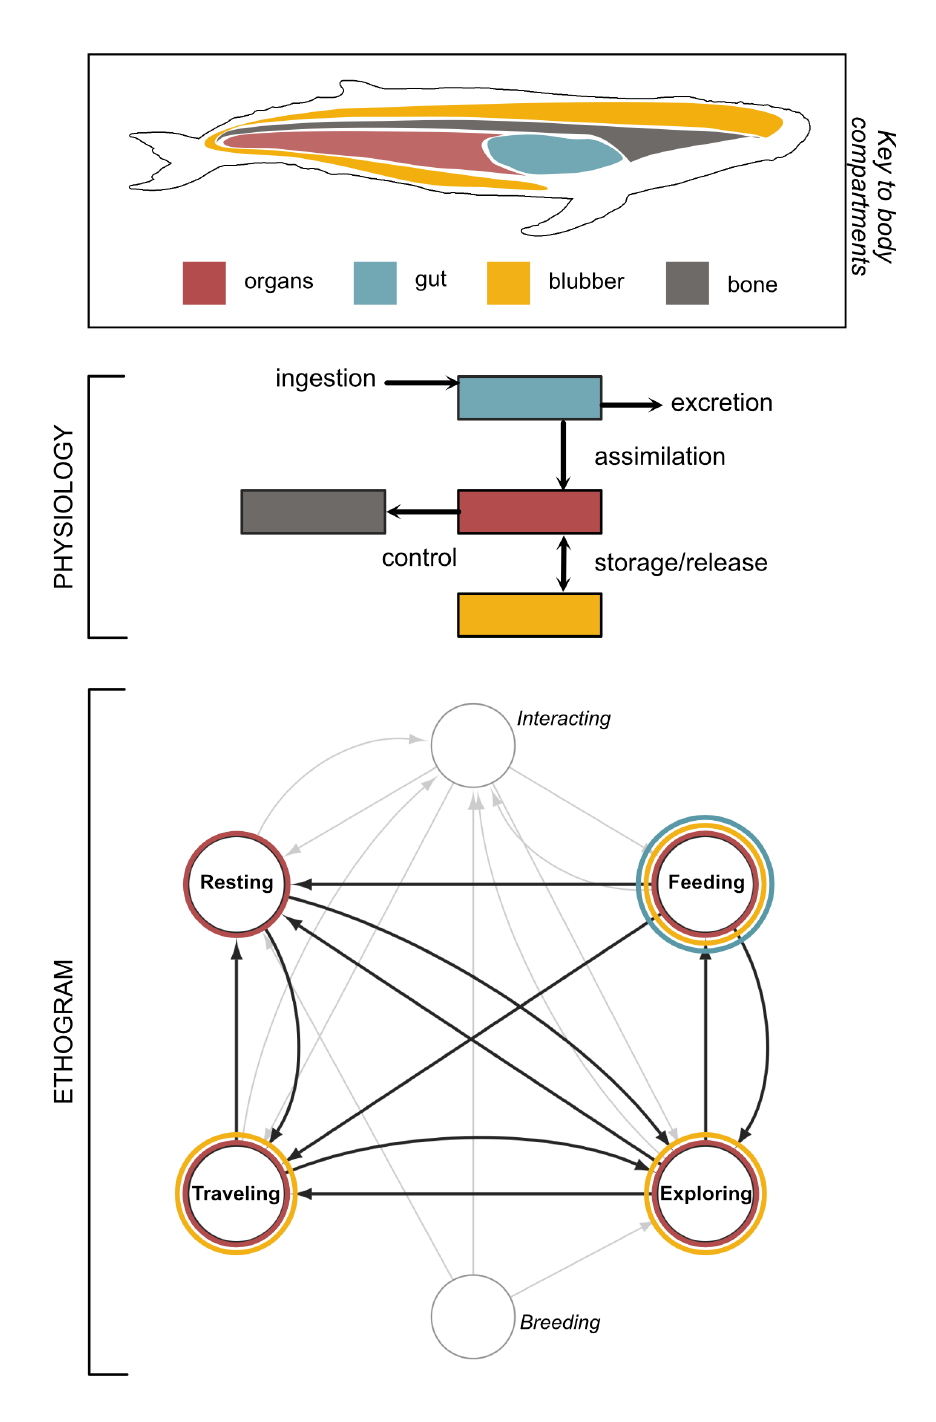
Figure 1. Concepts manipulated in the individual-based model framework. Each whale individual is described by two components: 1. The physiology and bioenergetics were described by exchanges between four body compartments, gut, organs, blubber and bone. 2. A generic, comprehensive ethogram was defined for the humpback whale based on the literature. Solid lines and arrows indicate the links between four behaviors treated by the model. The graph also indicates (in gray), two other behaviors that were not considered due to the lack of suitable energetic information. The ethogram graph was transformed into a transition matrix that defines the probability of maintaining one behavior or changing from one to another during